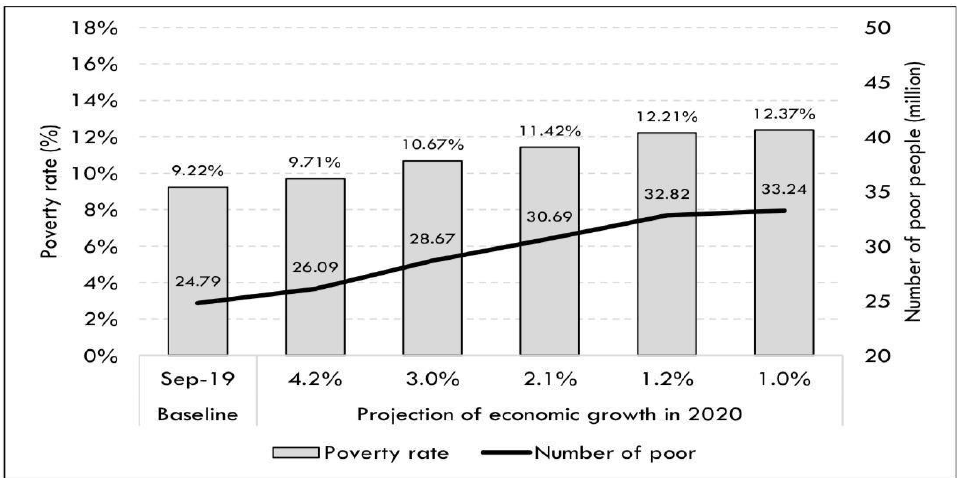
Figure 1 Projection of 2020 Economic